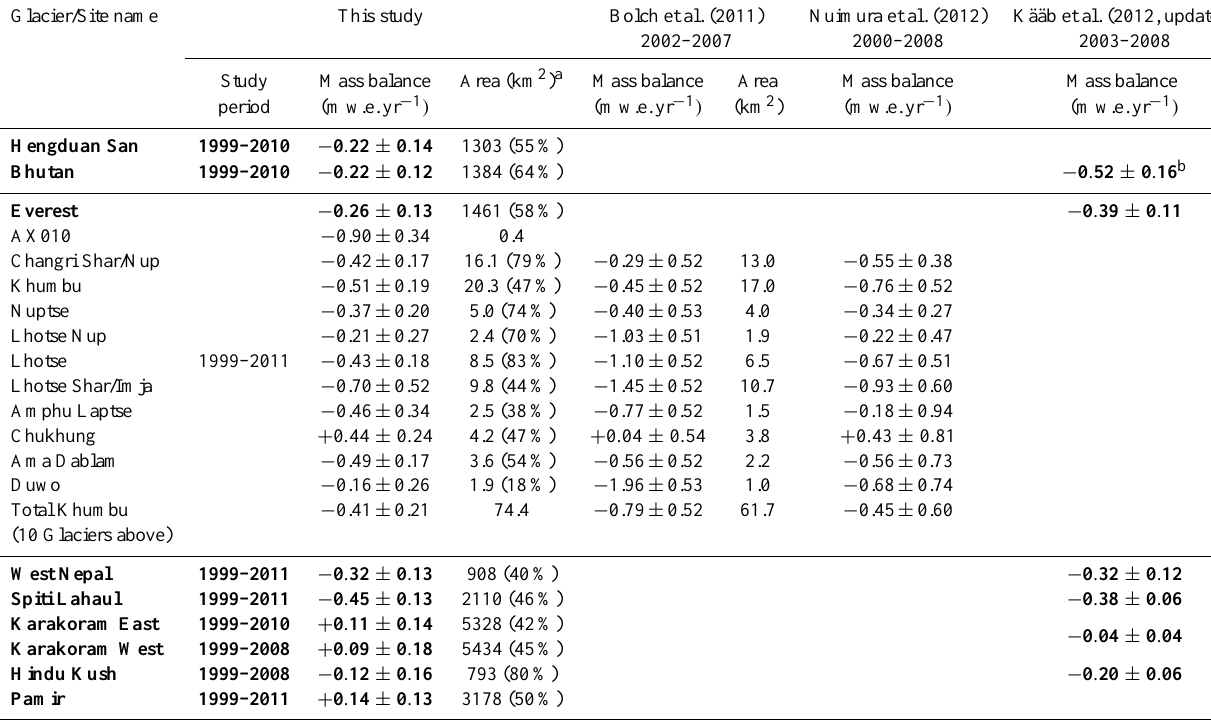
Table 5. Comparison of geodetic mass balances between this study and previous published results with overlapping study periods and similar geographic locations. Updated figures from Kääb et al. (2012) are averaged over 3 ◦ × 3 ◦ cells centered over the study sites of the present